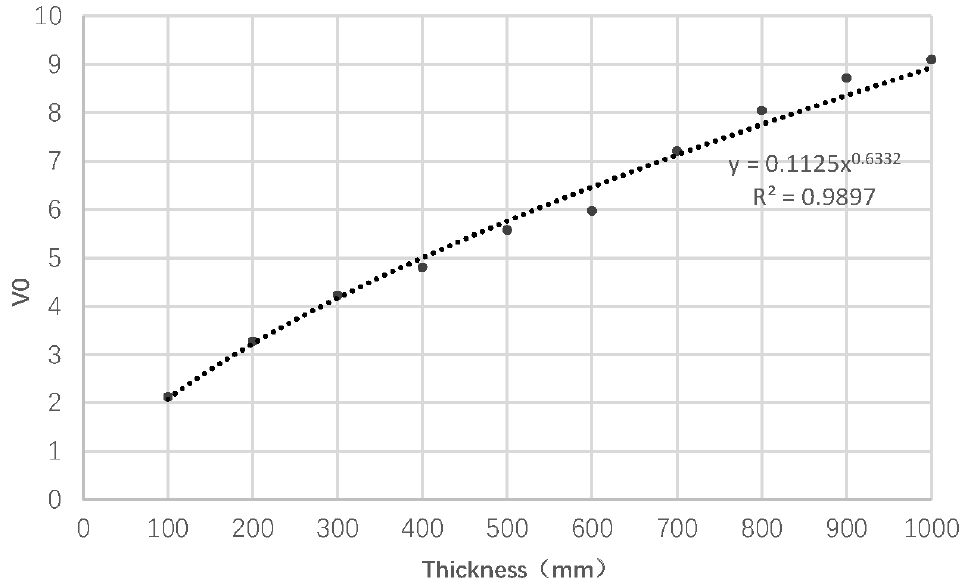
Figure 8. Fitting of the decay degree function.